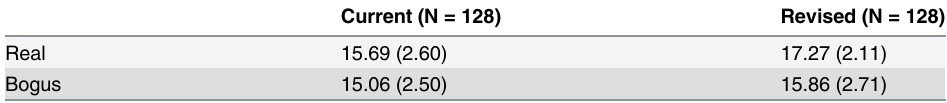
Table 6. Means and standard deviations for the total number of correct